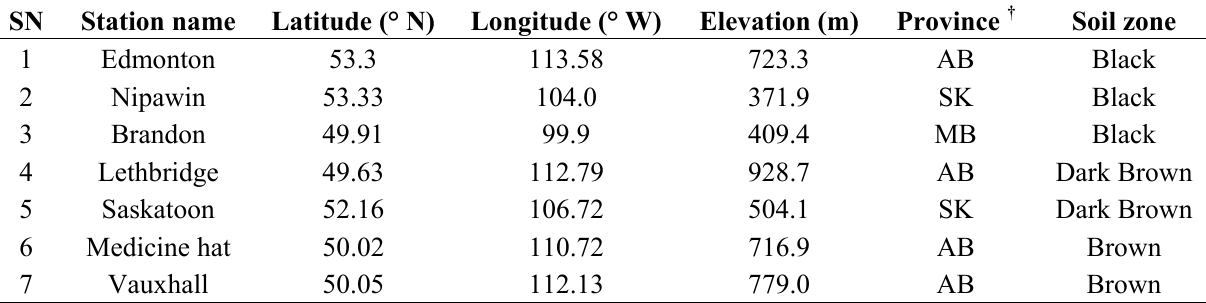
Table 1. Representative weather stations for the three major soil zones in the Canadian Prairies †